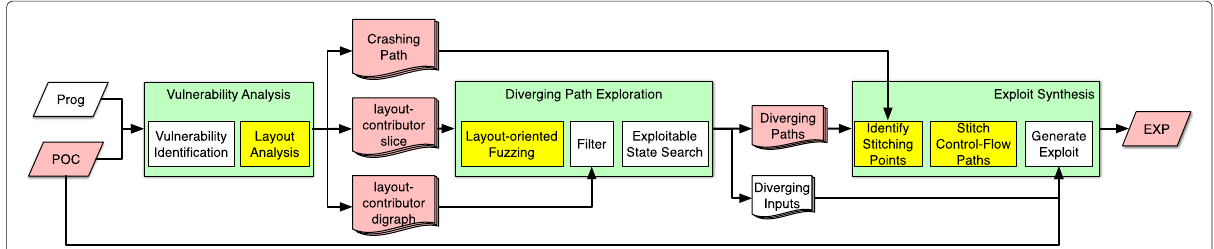
Fig. 2 Overview of Revery. It first analyzes the vulnerability in the crashing path and gets the layout-contributor digraph to characterize the vulnerability, then guides a fuzzer with this digraph to explore diverging paths and search for exploitable states, and finally stitches the diverging path with the crashing path to synthesize